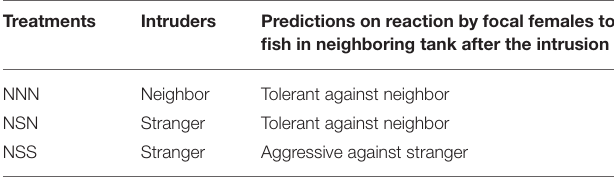
TABLE 1 | Predictions of focal-female reactions toward fish in neighbor tanks after fish intrusi on in the three treatments NNN, NSN, and NSS.